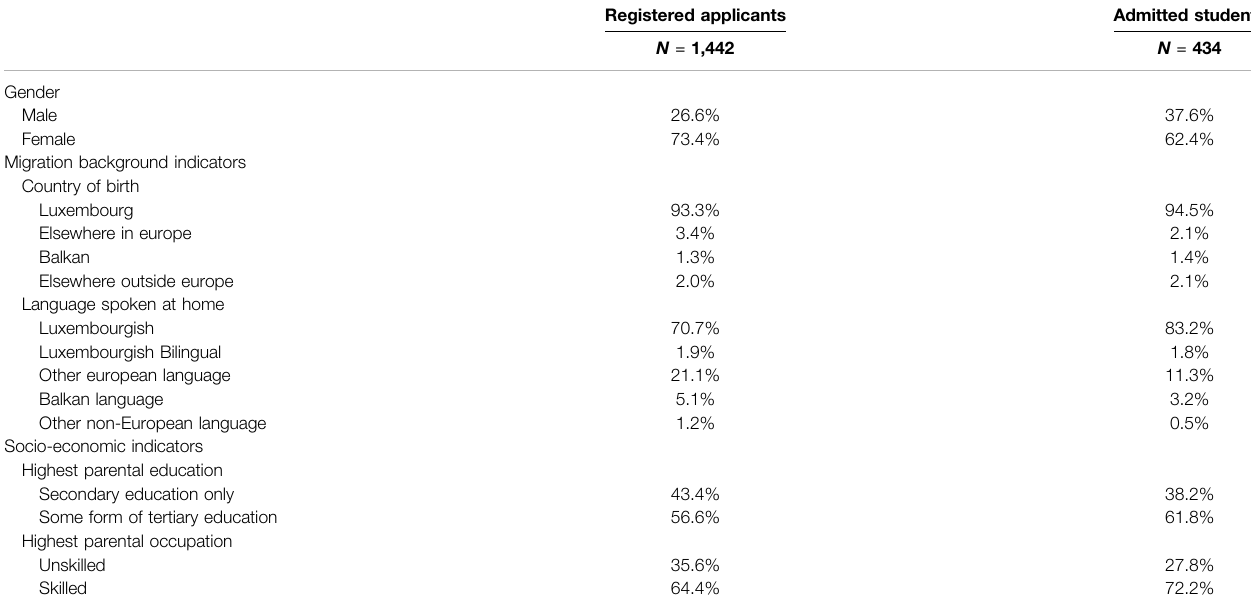
TABLE 3 | Characteristics of registered applicants vs. admitted students into the teacher education program (2015 –